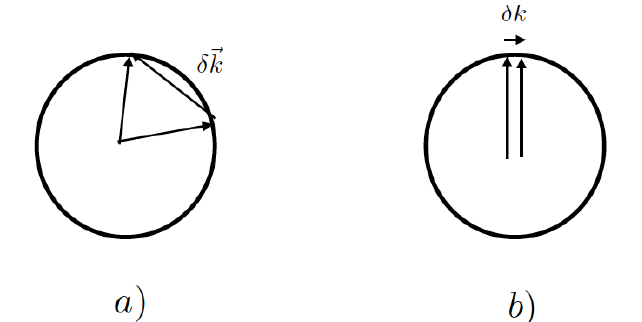
Figure 2 . Allowed kinematic con(cid:12)guration for framid-quasi-particle scattering. Diagram (a) in- volves an o(cid:11)-shell framid, which can be integrated out. (b) shows the interaction with a soft framid leading to near forward